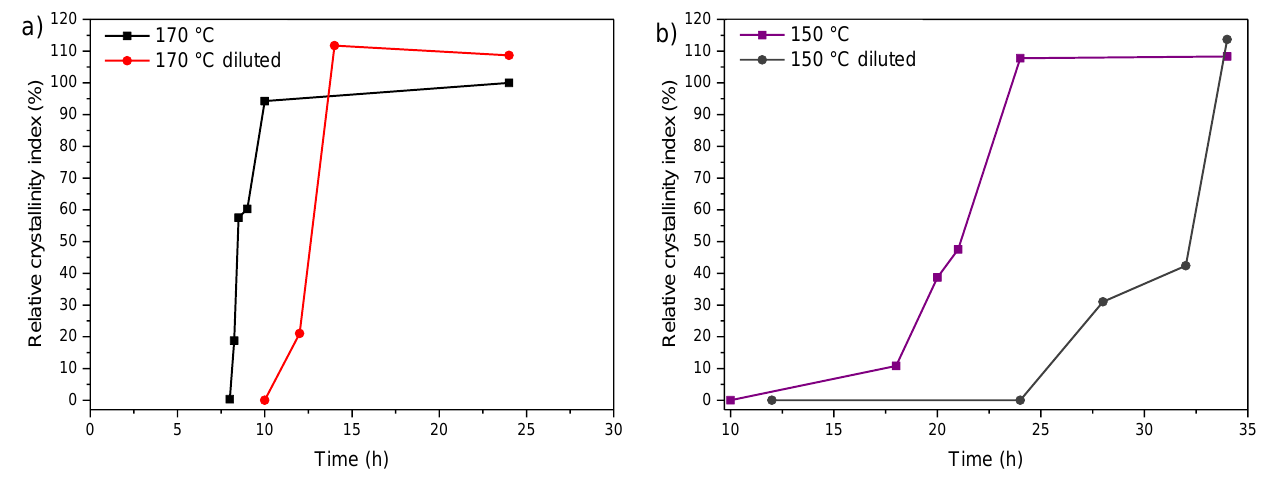
Figure A3. Comparative crystal growth curves for diluted and nondiluted sample series at 170 °C ( a ) and 150 °C ( b ).